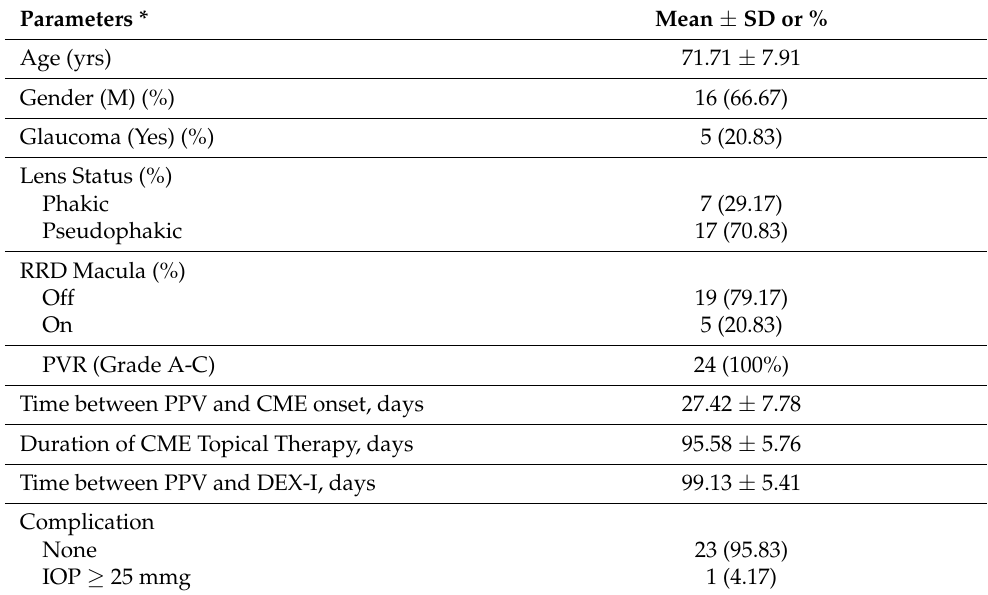
Table 1. Anamnestic and clinical characteristics ( n = 24).